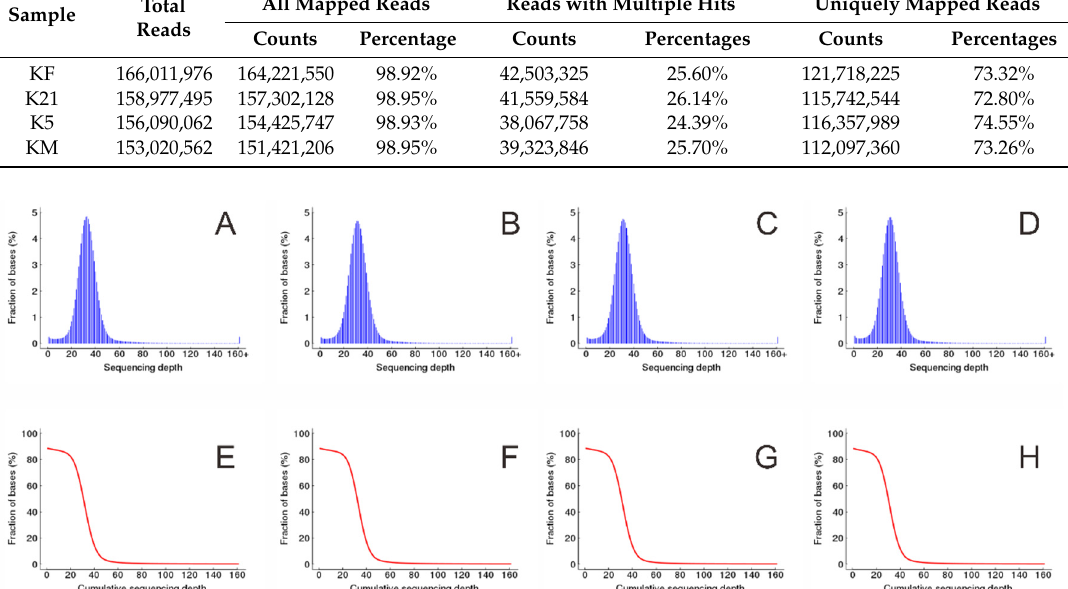
Table 2. Summary of reads mapped to reference genome.